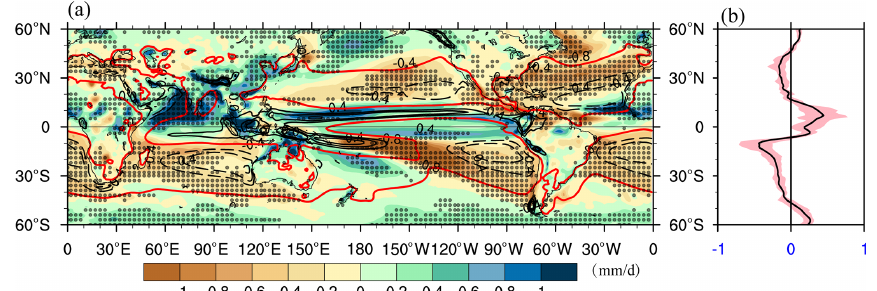
Figure 1. The simulated PmE changes in individual PlioMIP2 models. The zonal average of the PmE changes in each model is shown in panel (b) (units: mmd − 1